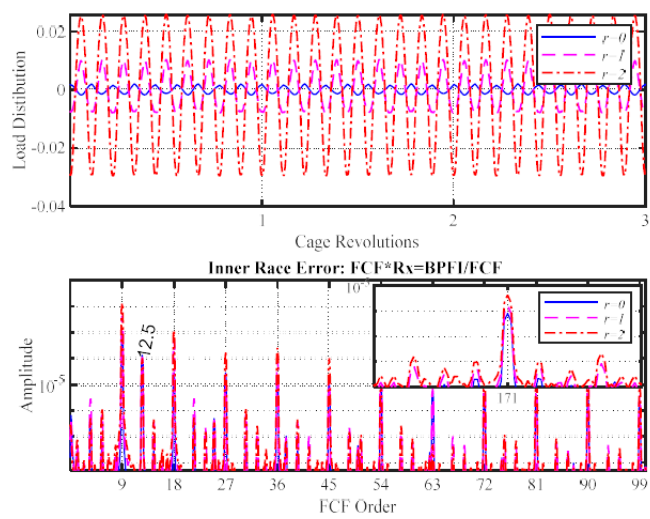
Figure 7. Dynamic force waveforms and spectra under different clearances and errors.